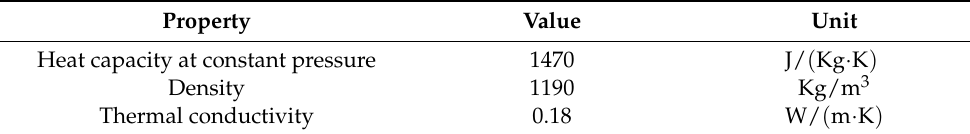
Table 1. Properties of acrylic plastic used for the SHC.